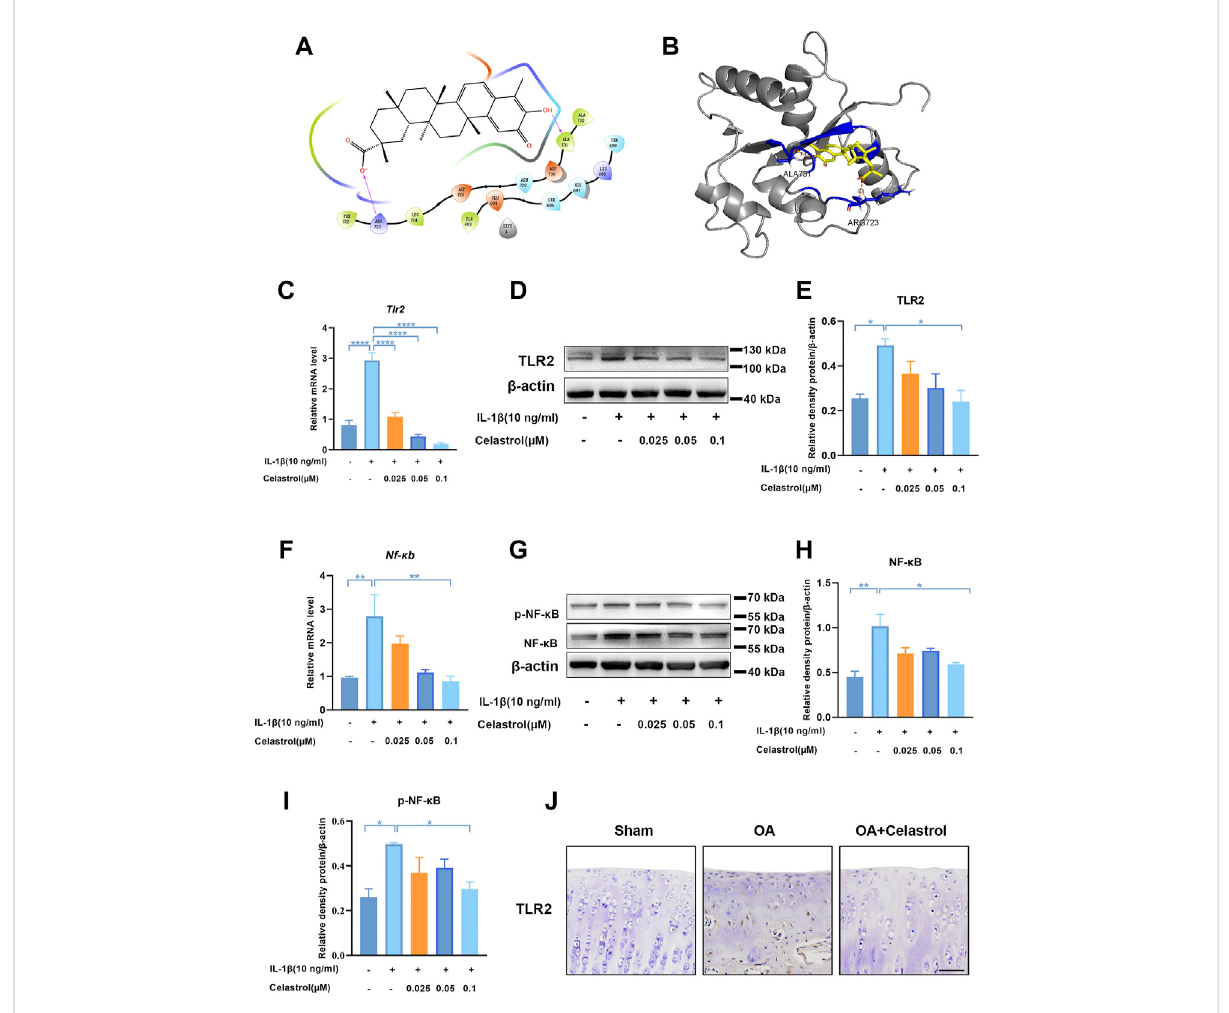
FIGURE 6 Celastrol inhibited TLR2-triggered signals in rat chondrocytes. (A,B) Interaction diagrams of celastrol docked to TLR2 using Maestro software. (C,F) The mRNA levels of TLR2 and NF- κ B in rat chondrocytes were assayed by real-time PCR. (D,G) Western blot results for TLR2, p-NF- κ B and NF- κ B in rat chondrocytes with or without celastrol. (E,H,I) Quanti fi cation of Western blot data from D and G. (J) Immunohistochemical staining for TLR2 intheaffectedjointcartilageofratsfrom differentgroups (scalebar: 50 μ m). All datarepresentmean ±S.E.M. * p < 0.05, ** p < 0.01,*** p < 0.001 and **** p < 0.0001. All experiments were repeated 3